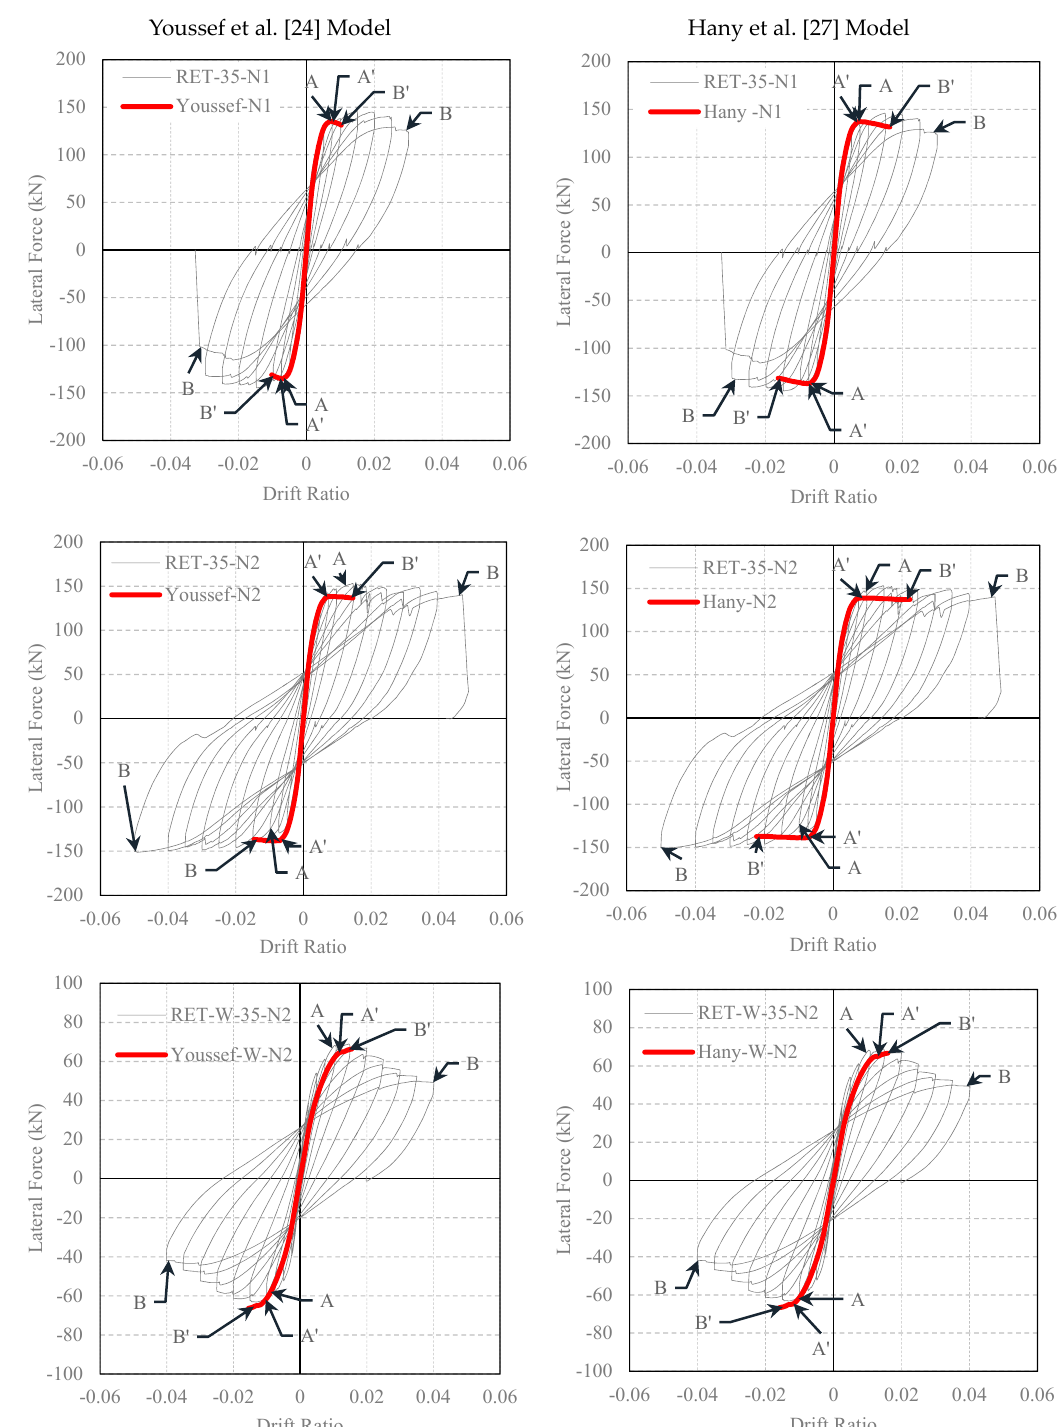
Figure 12. Comparison of experimental and analytical lateral load-drift relationships (confined concrete strength and strain capacity obtained by using Youssef et al. [24] and Hany et al. [27] models).